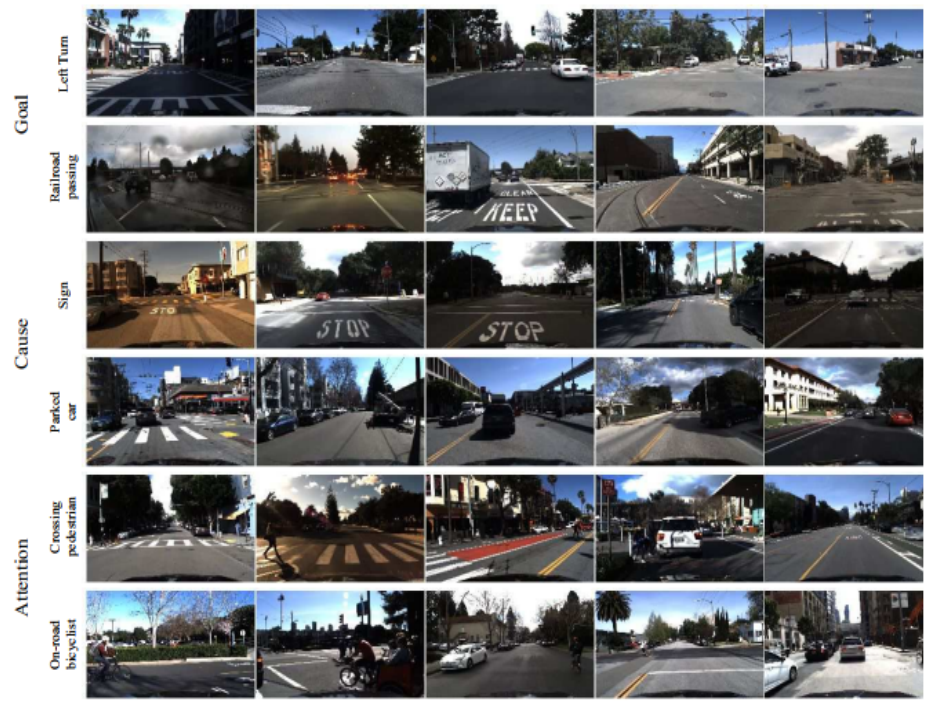
Figure 7. Divers on-road behavior scenarios acquired using an ego-vehicle. Four different annotation layers are proposed in the HDD dataset to describe the driver and the behaviors of his surround- ings